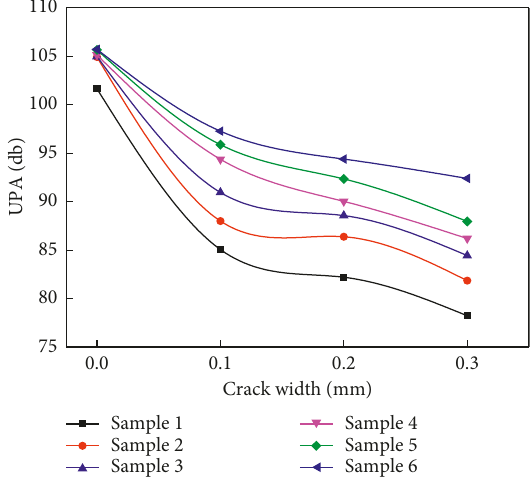
Figure 12: Variation of UPA with crack width.